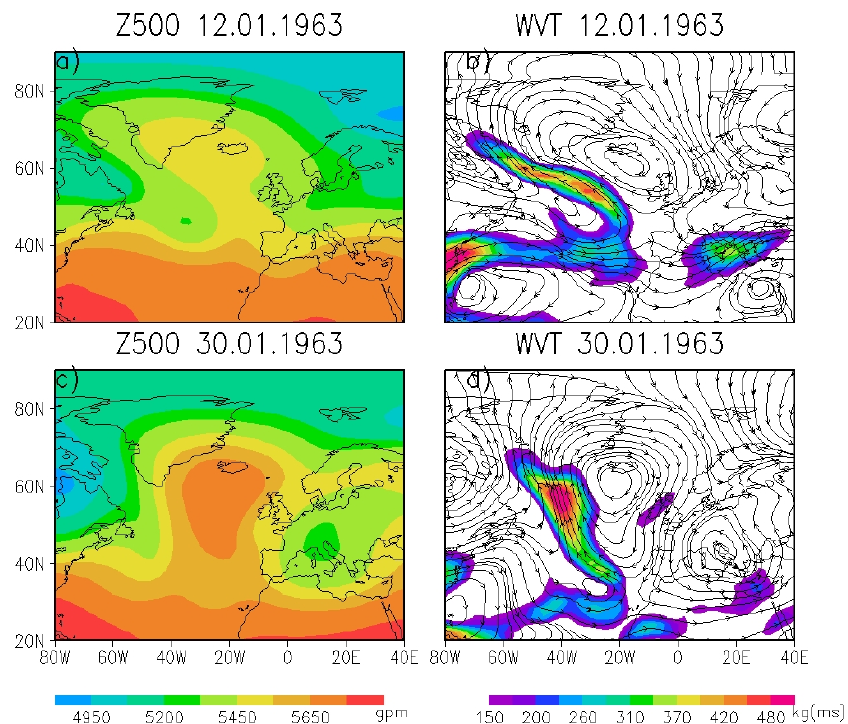
Figure 5. ( a ) 500 hPa geopotential height and ( b ) vertically integrated water vapor transport during 12 January 1963 when a CWB event occurred in the North Atlantic region. In ( b ), color represents the magnitude of WVT higher than 150kg/(ms) and arrows its direction; ( c , d ), as in ( a , b ), but for 30 January 1963, when an AWB event was recorded in the North Atlantic region. Units gpm and kg/(ms).